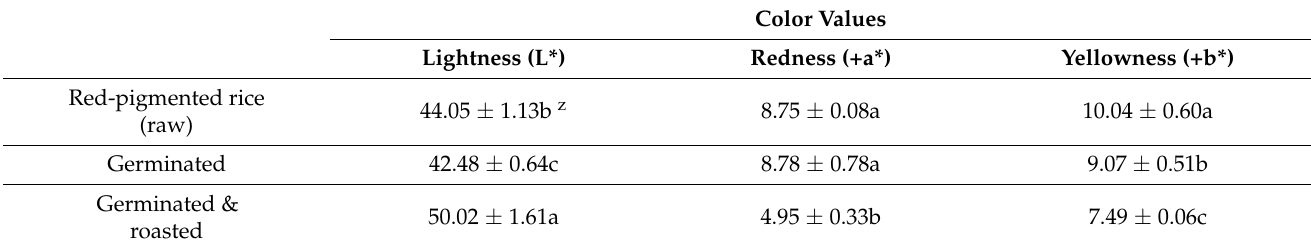
Table 2. Effects of germination and roasting on color values of red-pigmented rice.